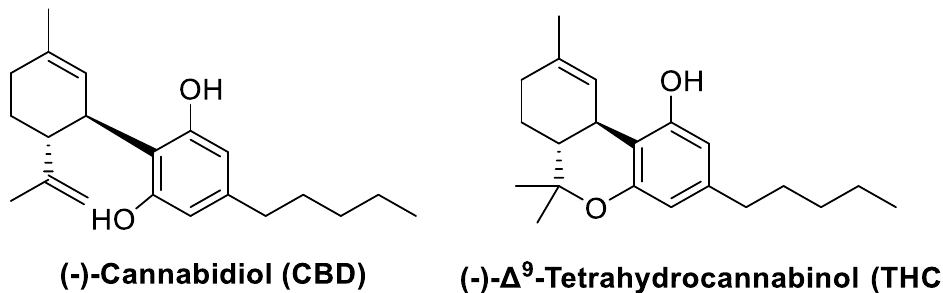
Figure 2. Chemical structures of cannabidiol and tetrahydrocannabinol.